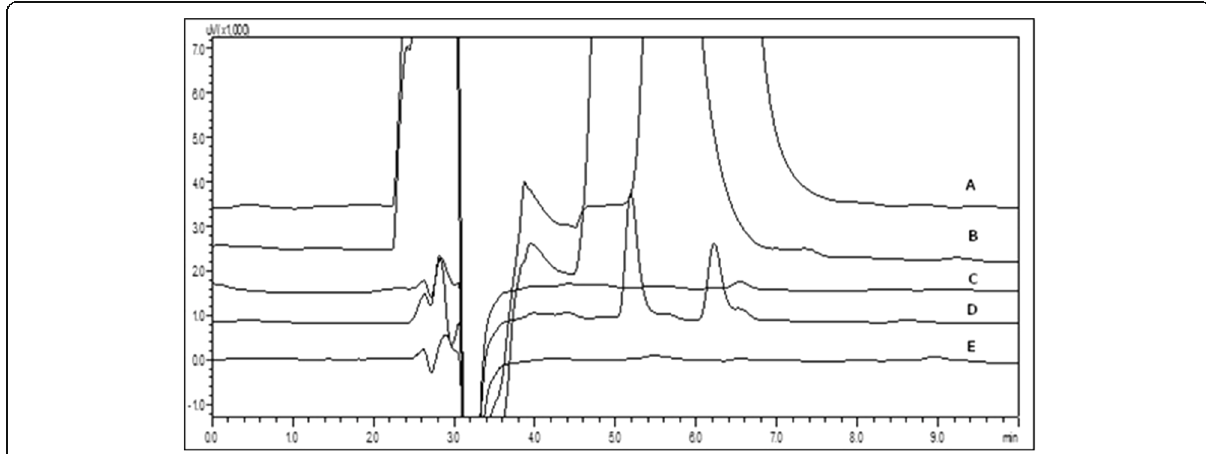
Fig. 2 Effect of mobile phase composition and CBZ (IS). Chromatograms of (A) LTZ, (B) CBZ, (C) blank plasma, (D) spiked plasma, and (E) diluent using ACN and acetate buffer pH 4.5 (50:50 %v/v) at 1